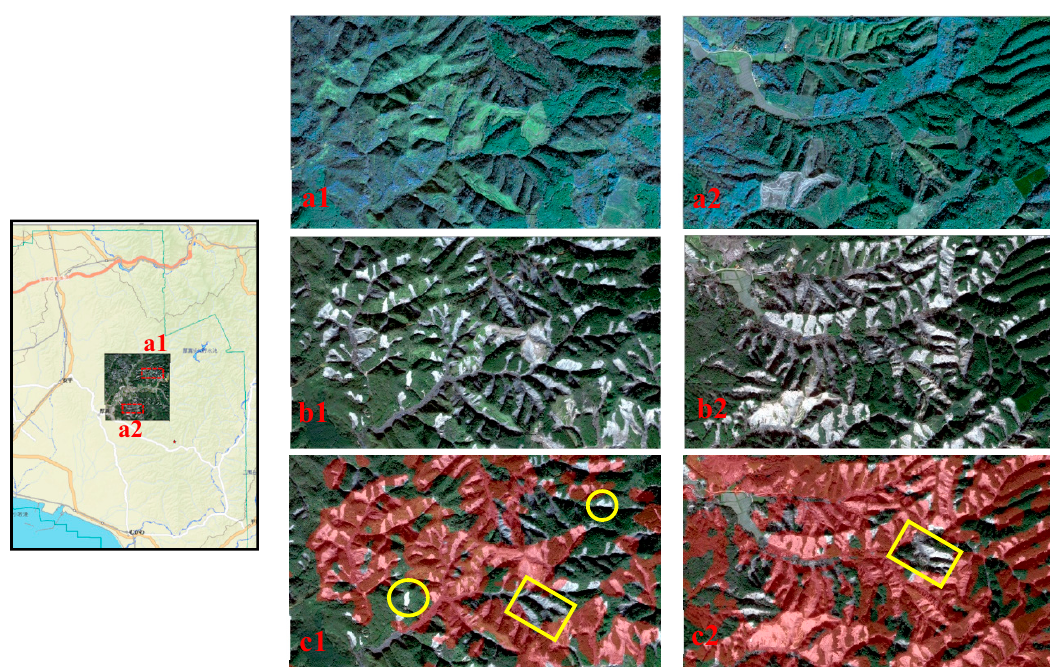
Figure 9. Visual comparison of classification results (case 1) with the pre- and post-event high-resolution optical images. a1 and a2 are from WorldView-2 taken on 24 October 2017; ( b1 and b2 ) are from GeoEye-1 image taken on 20 October 2018; c1 and c2 are the identified landslides overlaid on the GeoEye-1 image.